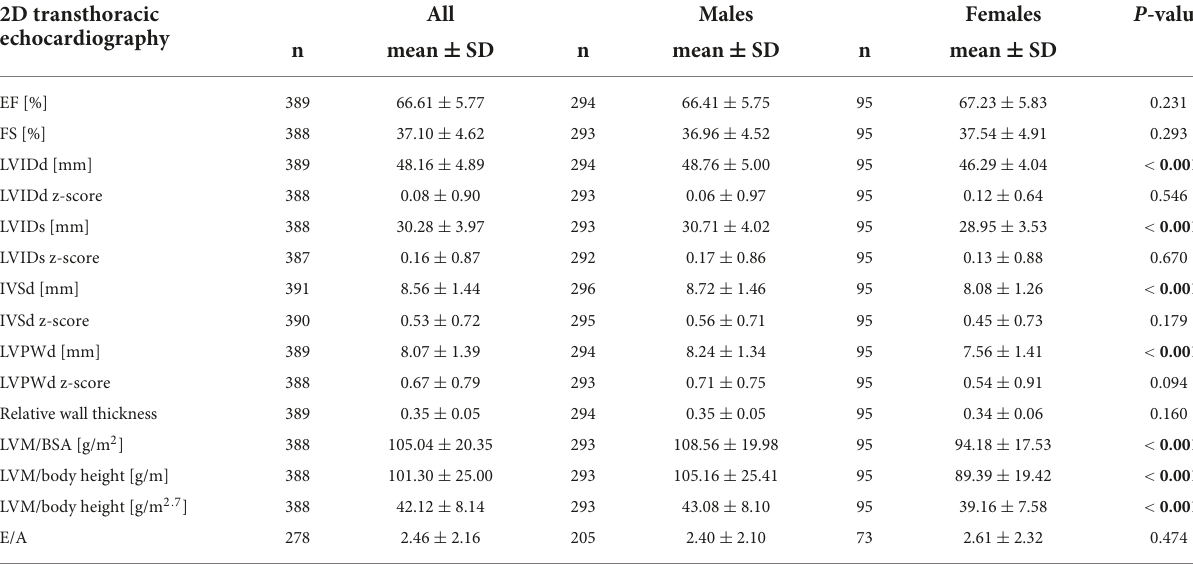
TABLE 2 Results of echocardiographic data for all participants and separately for male and female athletes. 2D transthoracic